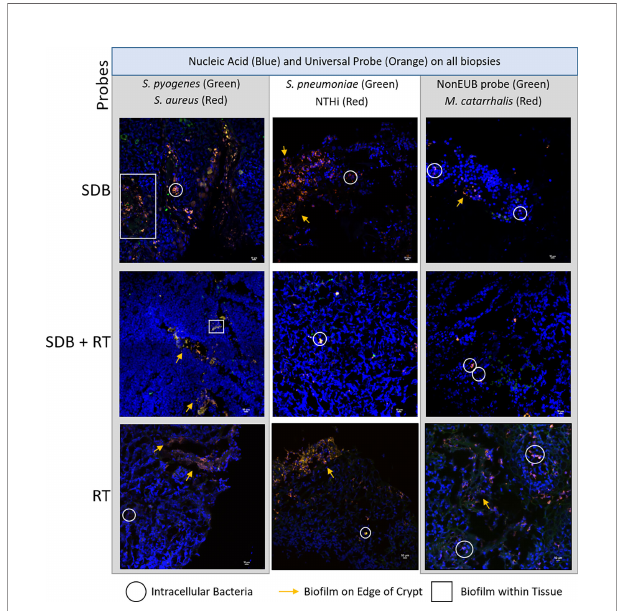
FIGURE 3 | Representative maximum projections of intracellular bacteria, bio fi lms on surfaces and within tonsillar tissue from children with SDB, SDB+RT and RT. Scale bars represent